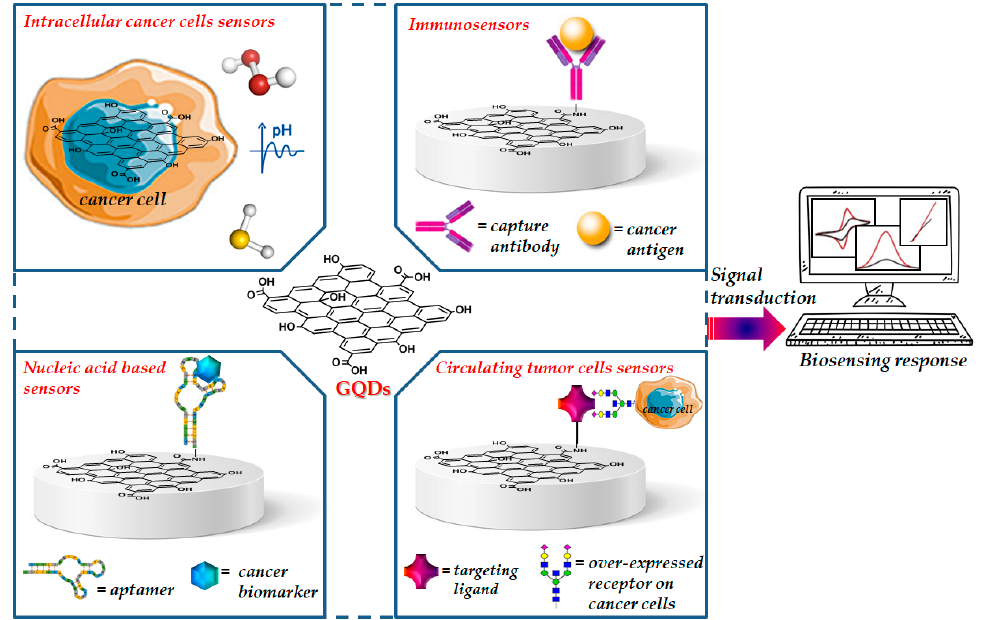
Figure 1. Representative image of functionalized GQDs for cancer biosensing.